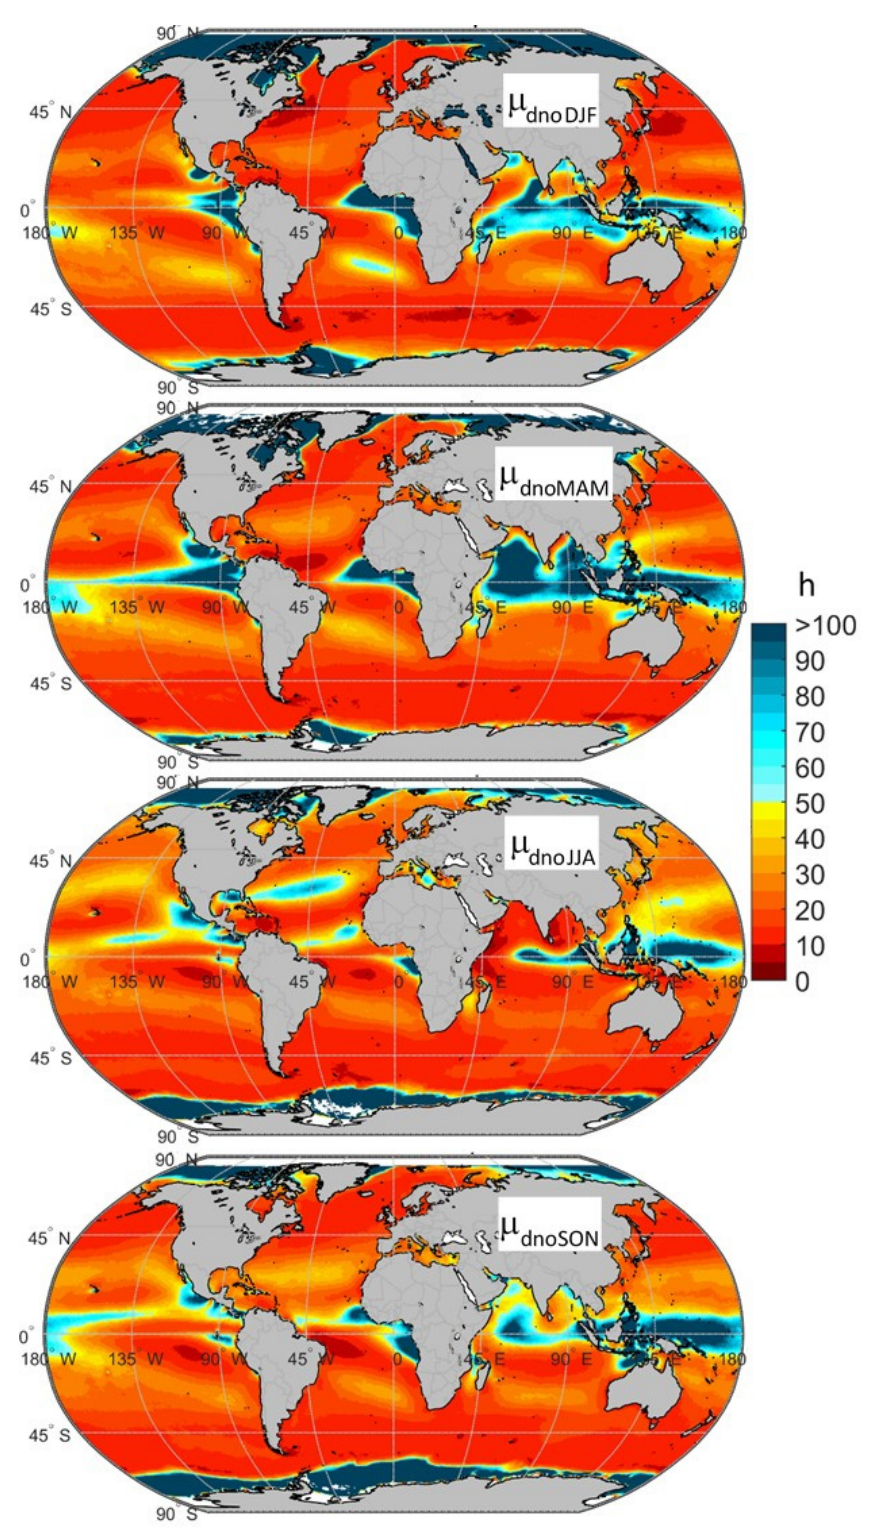
Figure 13. Global distribution of the mean seasonal duration of non-operability intervals. It is noticeable the large seasonal variability in the Indian Ocean affected by the Asian monsoon as in the Bengal and Arabian seas. In the trade wind belts, the seasonal variability of µ dno is smaller, with a general N-S displacement in latitude of the areas with minimum µ dno durations. The largest areas of minimum dno durations (5–10 h) occur during